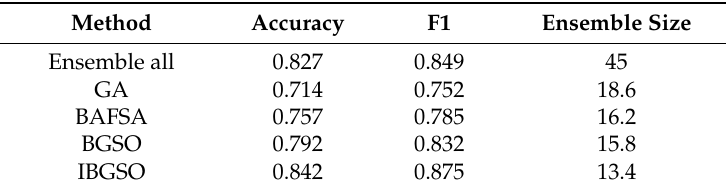
Table 13. Performance comparison for the five approaches using the DSA.